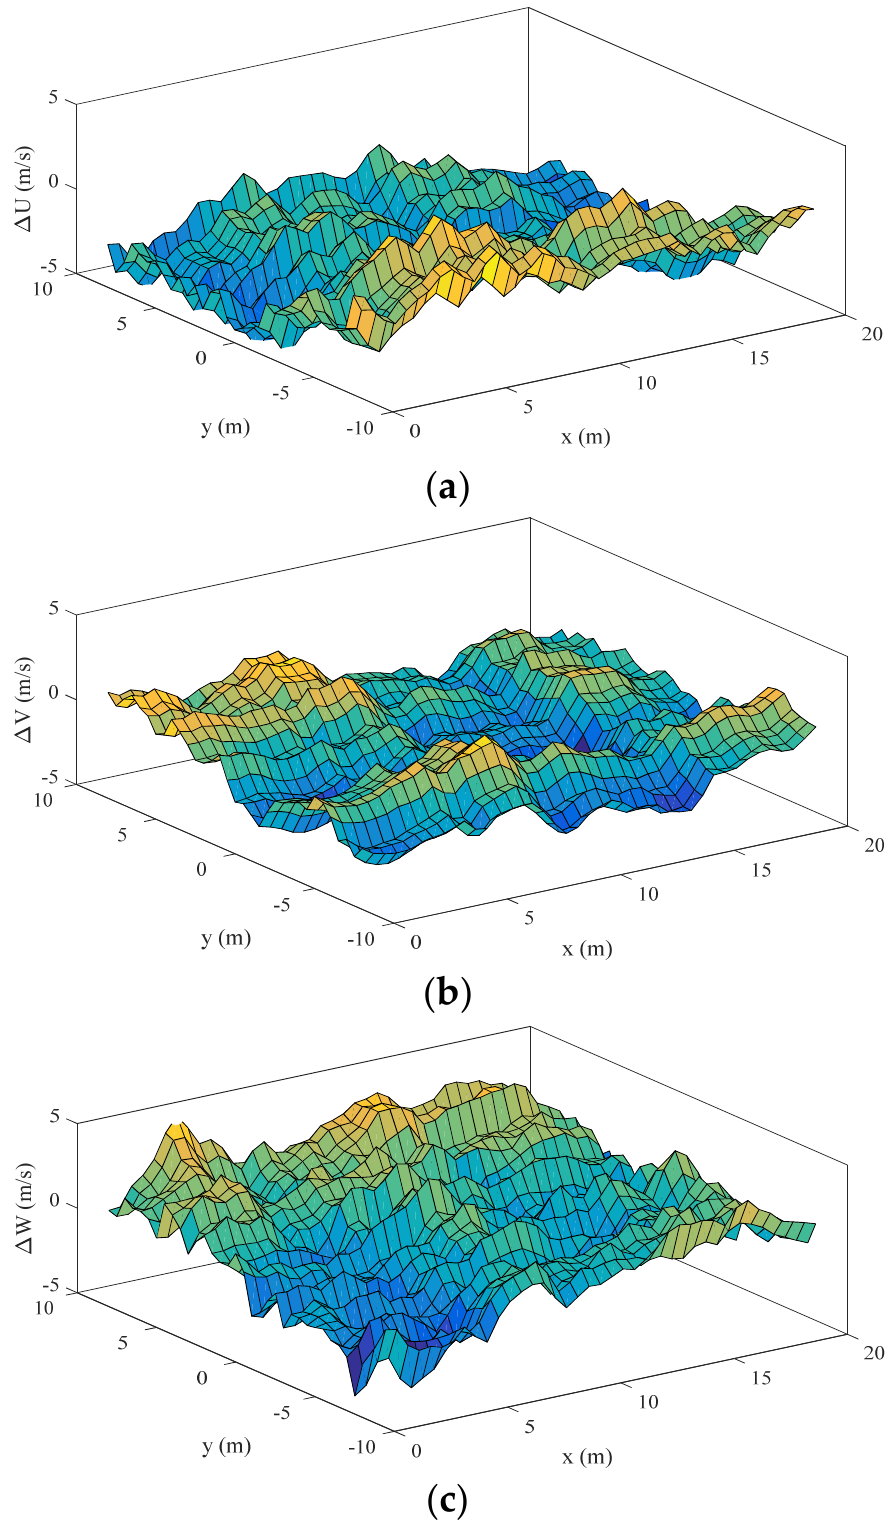
Figure 3. A slice of turbulence components on the horizontal plane. ( a ) Longitudinal turbulence component; ( b ) Lateral turbulence component; ( c ) Vertical turbulence component.